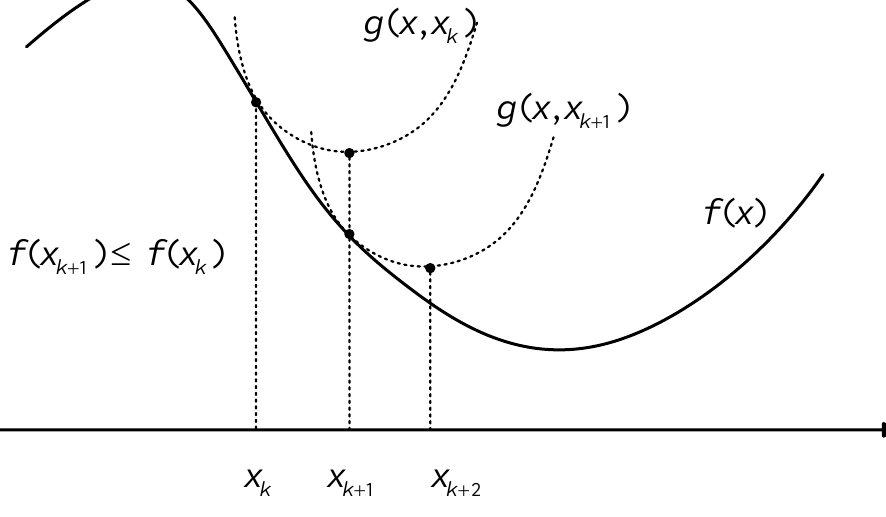
Figure 1. MM algorithm procedure.